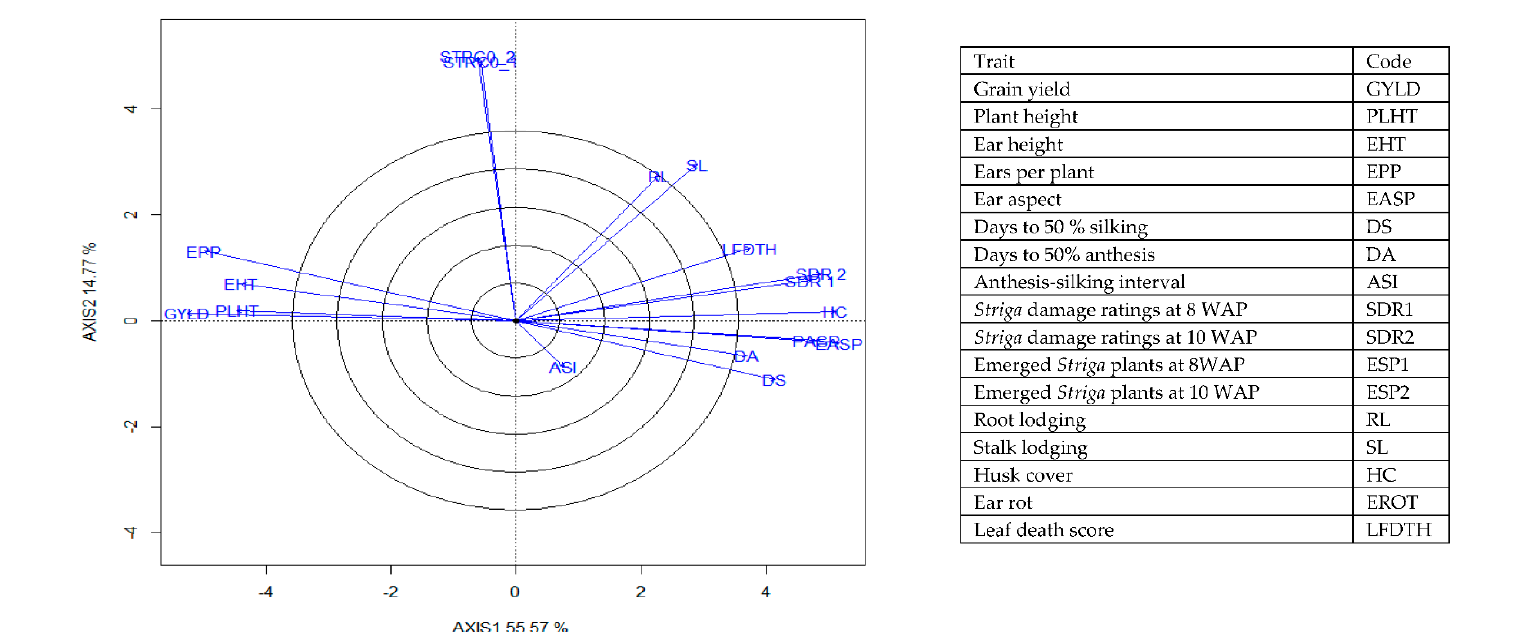
Figure 6. A vector view of the genotype-by-trait biplot showing interrelationships among all traits of 196 early maturing pro-vitamin A hybrid maize evaluated under Striga infestation at Mokwa in 2016 and 2017 and at Abuja in 2017. The biplot was based on genotype-focused singular value partitioning (‘SVP = 2) and is therefore appropriate for visualizing the relationships among traits. Principal component (axis 1) and axis 2 for model 2 explained 70.34% of the variation among traits.